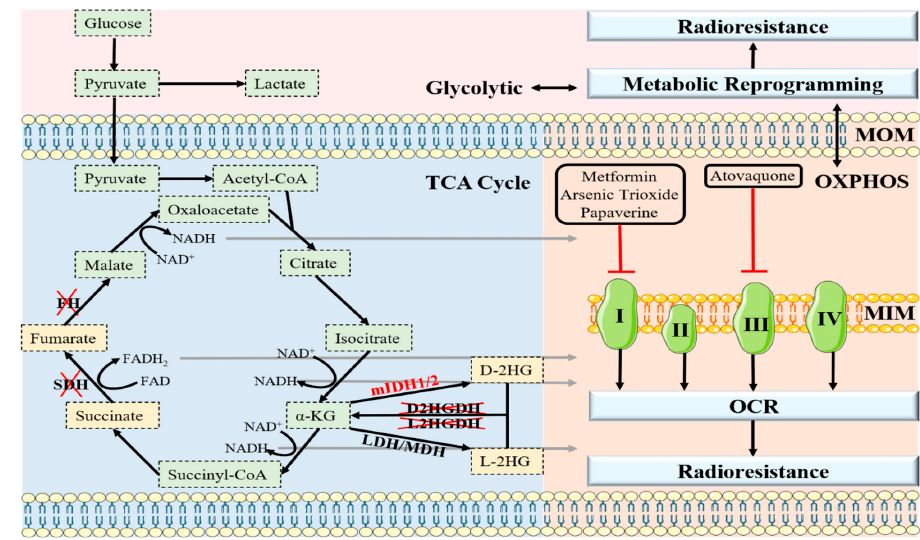
Figure 3. A schematic summary of glycolysis, TCA cycle, and OXPHOS in regulating radioresistance. (1) In the cytoplasm, pyruvate produced by glycolysis crosses the outer mitochondrial membrane and participates in the TCA cycle, and the subsequently produced NADH and FADH 2 are oxidized by a stepwise, continuous enzymatic reaction on the ETC located in the inner mitochondrial membrane, thereby releasing energy for the body to utilize. (2) Inactivation of FH, SDH, D2HGDH, and L2HGDH, mutation of IDH1/2, or promiscuous activity of MDH/LDH can induce accumulation of oncometabolites. On the one hand, oncometabolites promote tumorigenesis; on the other hand, they also amplify the benefits of radiotherapy. (3) Enhancing OCR or favoring the reprogramming of tumor cells’ metabolic pathways induces radioresistance. Abbreviations: TCA cycle—tricarboxylic acid cycle, ETC—electron